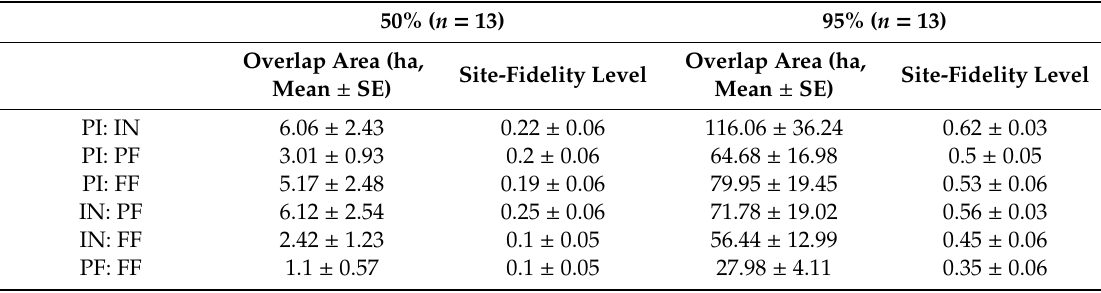
Table 2. Site fidelity of Black-necked Crane among four breeding stages (mean ±